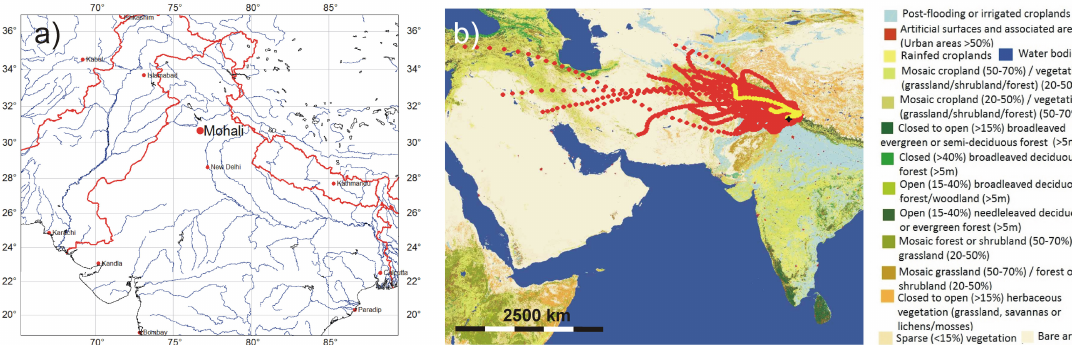
Figure 2. (a) Location of the city of Mohali in the northwest Indo-Gangetic Plain (30.667 ◦ N, 76.729 ◦ E, 310ma . s . l . ) (b) 72h back trajecto- ries of air masses that arrived at the site (site shown as black marker) every day from 1 May 2012 to 31 May 2012 at 14:30LT (UTC + 05:30) superimposed on a land classification map (courtesy ESA GlobCover 2009 Project).